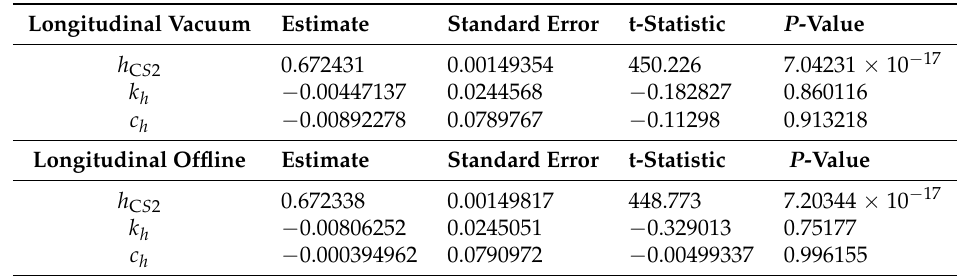
Table 4. The parameters of fitting h S 2 = h C S 2 + k h homogeneity of the vacuum and offline the vortex. The three parameters are identical within errors for the vacuum and offline. k h vanishes within errors, the negative sign would indicate the absence of long range fluctuations of the color vector.